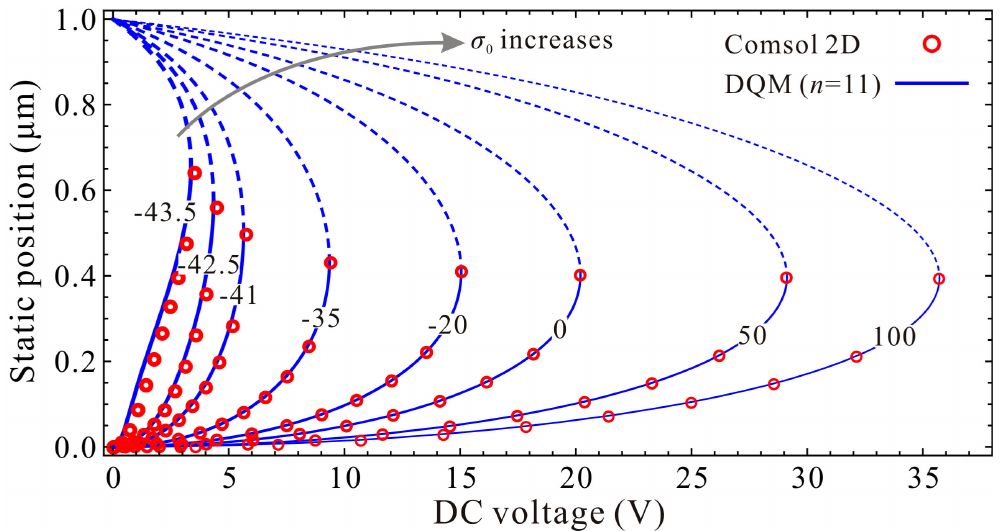
Figure 11. Quantitative property of the static position versus DC voltage for different residue stress (Unit: MPa).